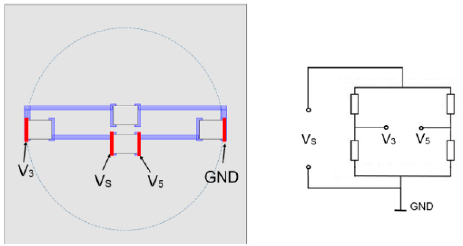
Figure 3. The detail of the model geometry: the LTCC sensor structure with the thick-film resistors (on the membrane) connected in the Wheatstone bridge with the metal connection paths and the electric scheme.